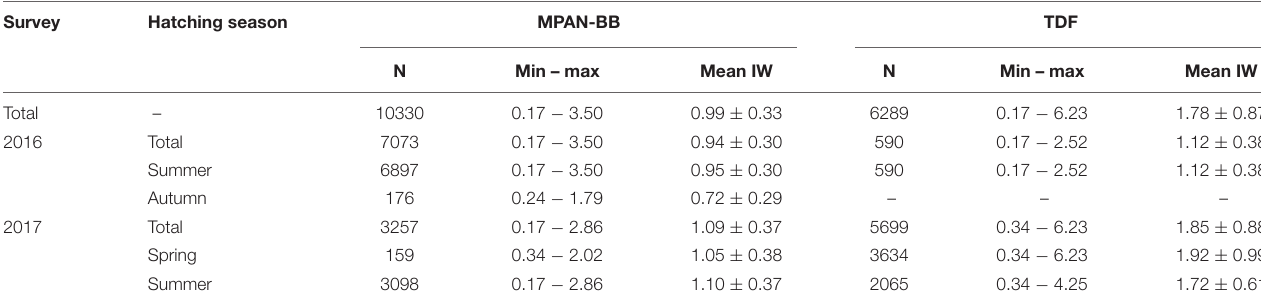
TABLE 2 | Minimum (min), maximum (max) and mean otolith increment widths (IW; µ m) of Fuegian sprats Sprattus fuegensis analyzed in the Marine Protected Area Namuncurá-Burdwood Bank (MPAN-BB) and Tierra del Fuego (TDF). Survey Hatching season MPAN-BB